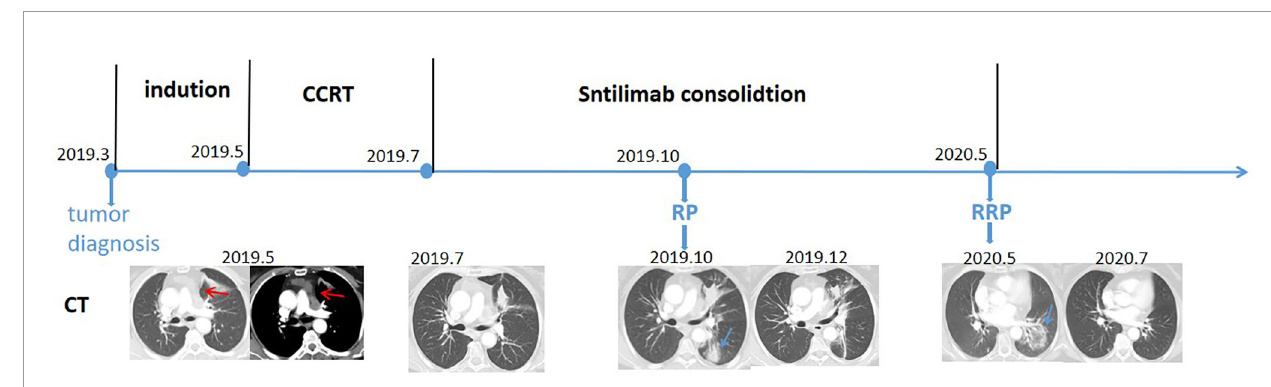
FIGURE 1 | Timeline of the major treatment process and CT evaluation of the patient since diagnosis. CT, computed tomography; CCRT, concurrent chemoradiotherapy; RP, radiation pneumonitis; RRP, radiation recall pneumonitis. Red arrow: tumor site; blue arrow: pneumonitis